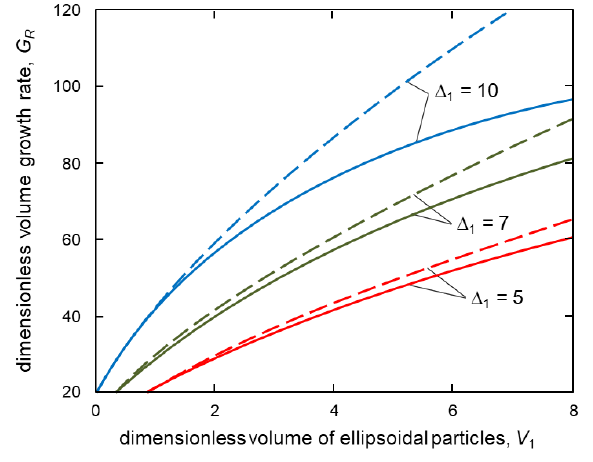
Figure 3. The growth rate G R of ellipsoidal crystals as a function of their volume V 1 at a different melt supercooling ∆ 1 . The solid and dashed curves are plotted for binary ( C l = 55 at%) and one-component ( C l = 0) melts, respectively. The model parameters are [43]: λ l / ( ρ s L ) = 2.75 · 10 − 8 m 2 K − 1 s − 1 , a = 1.26 · 10 − 8 m, β ∗ = 10 − 4 m K − 1 s − 1 , m = 8.78 K at% − 1 , k 0 = 0.86, D = 5.27 · 10 − 9 m 2 s − 1 , T l = 2 · 10 3